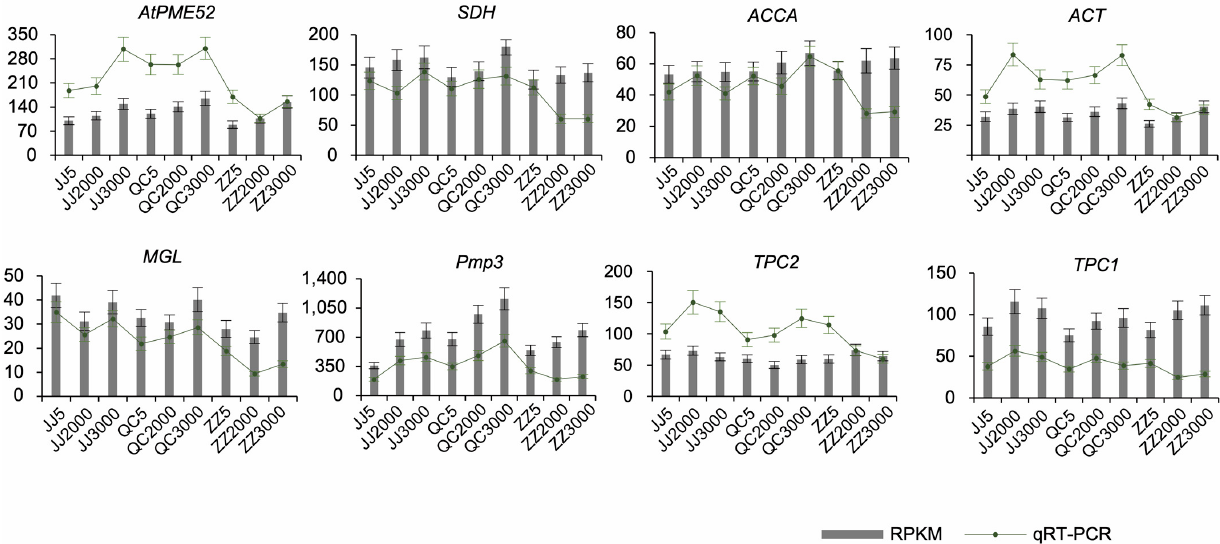
Figure 8. qRT-PCR analysis of seedlings of P. orientalis propagated in different methods from donors at different ages under low-temperature stress. Data are from three biological replicates and three technical replicates. The di ff erential expression analysis was conducted based on the 2 −ΔΔ ct method.